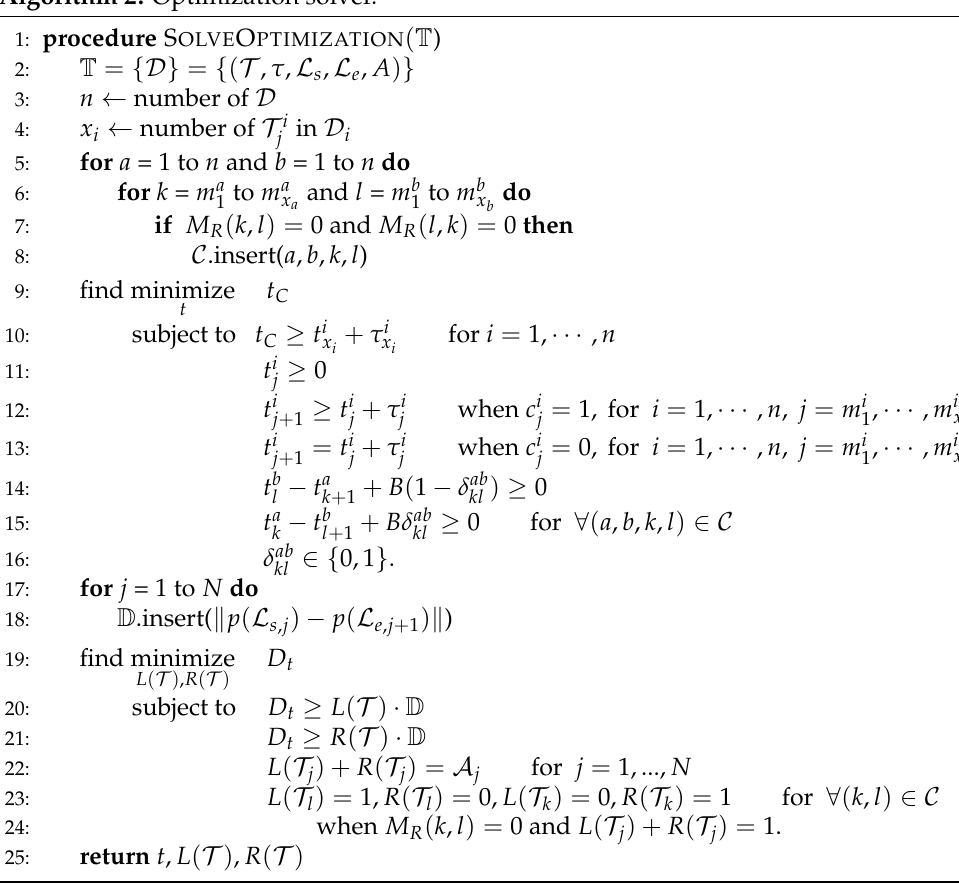
Algorithm 2: Optimization